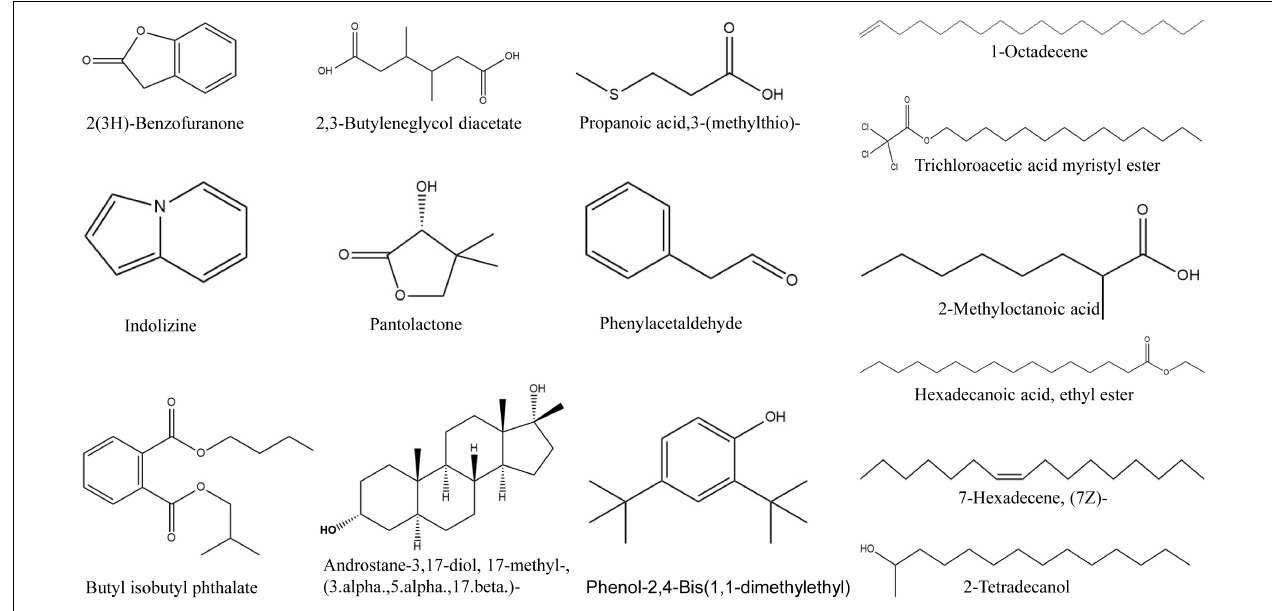
FIGURE 7 | Chemical structures of the identified compounds of the strain QN1NO-4 extract by